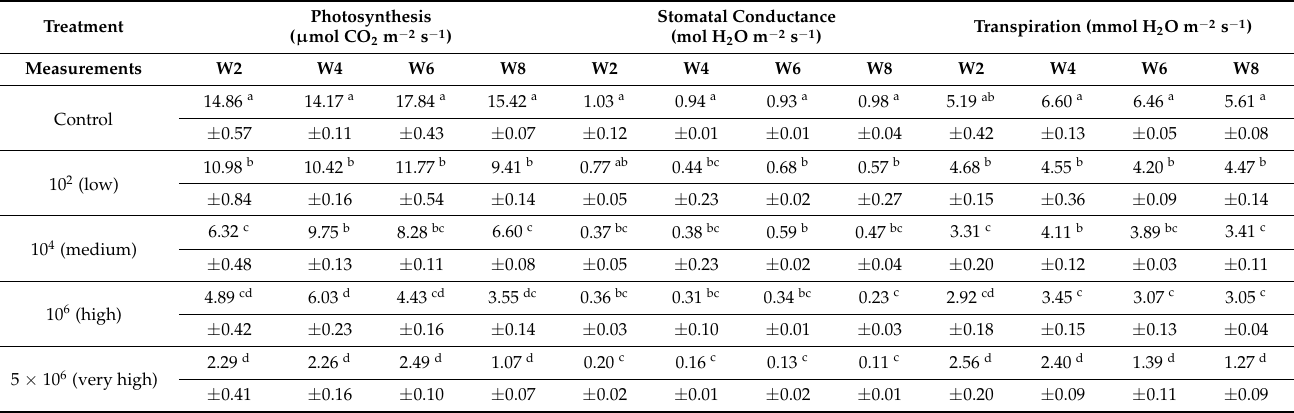
Table 1. Mean values ± standard error of the plant physiological data for all treatments.